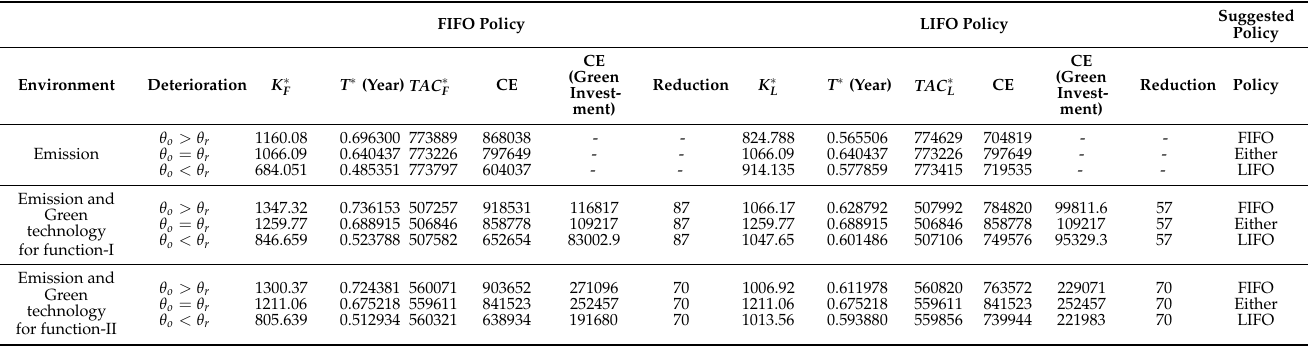
Table 4. Total optimal cost of inventory system under emission and green